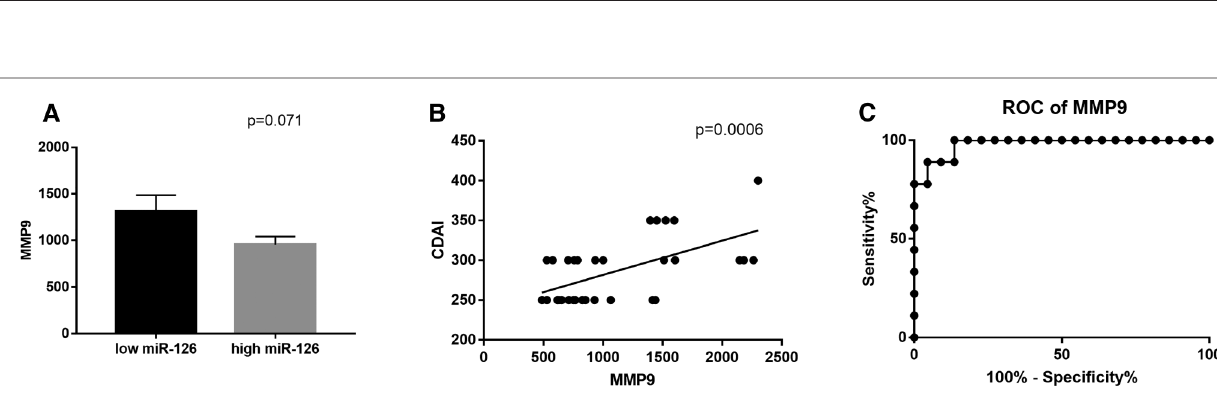
FIGURE 2 | ( A ) Circulating levels of MMP9 and ( B ) miR-126, measured in the plasma of CD patients with ( n =9) or without intra-abdominal fi stulas ( n =22). Data are expressed as mean±SE **** p <0.0001 and * p <0.05 by Mann-Whitney test.